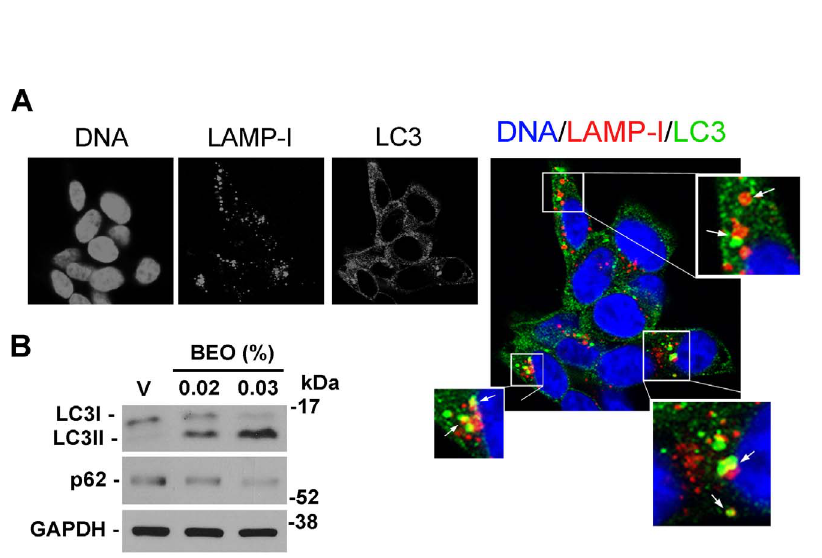
Figure 4. Fusion of autophagosomes and lysosomes in BEO-treated cells. ( A ) SH-SY5Y were treated with BEO 0.02% for 15 min, fixed and double stained with LC3 and LAMP-1 antibodies. Nuclei were counterstained with DAPI. Representative images were taken with a confocal microscopy and higher magnification views of the boxed area from the merged image are shown. White arrows indicate areas of fusion (yellow signal) between LC3 positive autophagosomes (green) and LAMP1 positive endosomes and/or lysosomes (red) indicative of a functional autophagic maturation. ( B ) Immunoblot showing the early conversion of LC3I into LC3II and the reduction of p62 following 15 min incubation with BEO. GAPDH was used as loading control. Images are representative of three independent experiments. (V 5 vehicle, 0.018% ethanol).